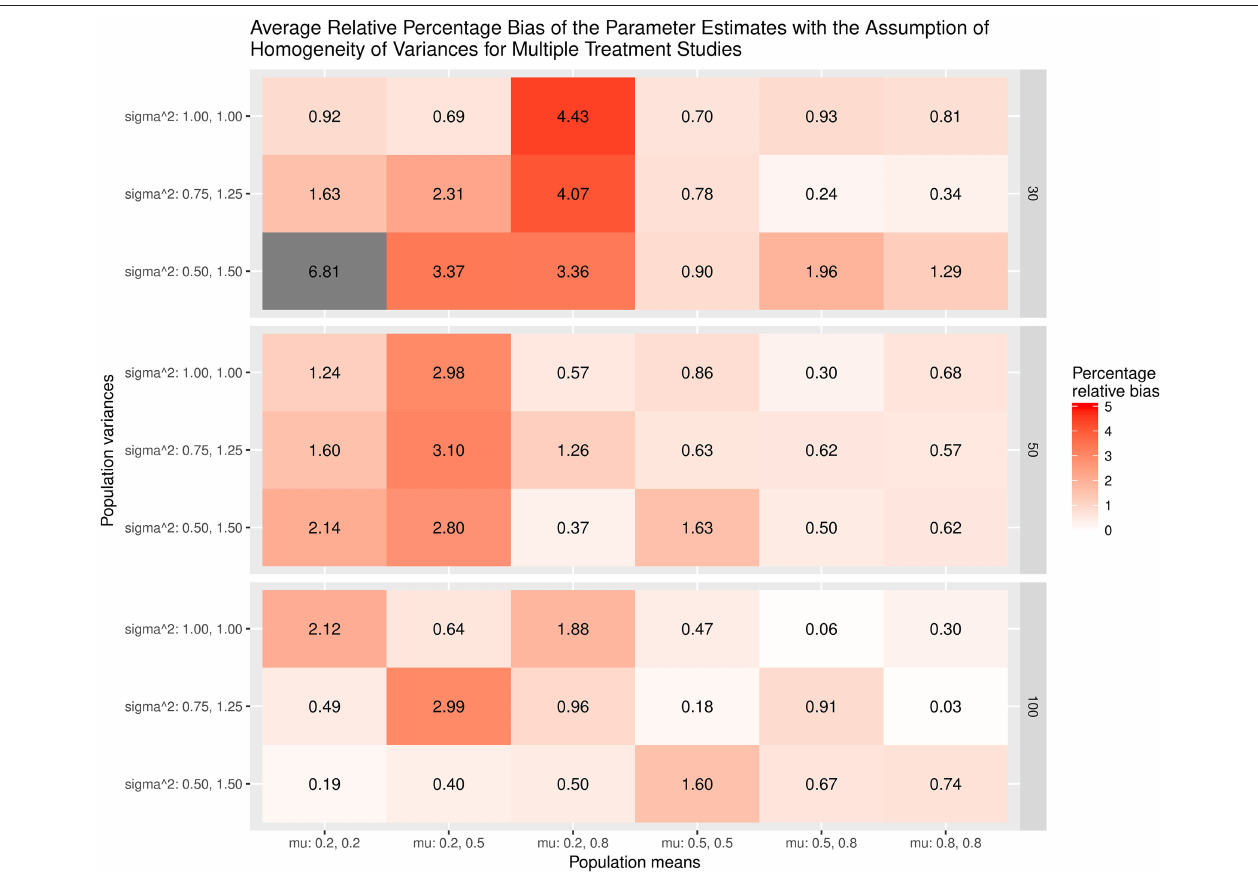
FIGURE 3 | Relative bias of the average of the parameter estimates for the multiple treatment studies with the assumption of homogeneity of variances.